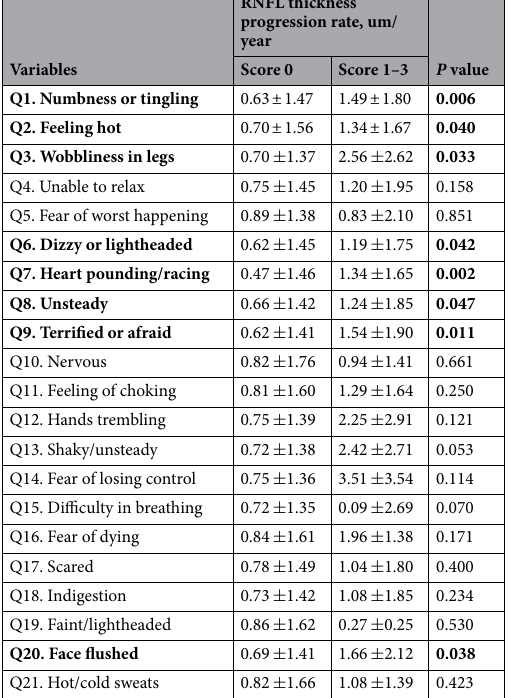
Table 4. The questions on the BECK anxiety inventory (BAI) associated with RNFL thickness loss. The comparison was performed using independent samples t-test. Statistically significant values are shown in bold. Continuous data are mean ± mean standard deviation unless otherwise indicated.